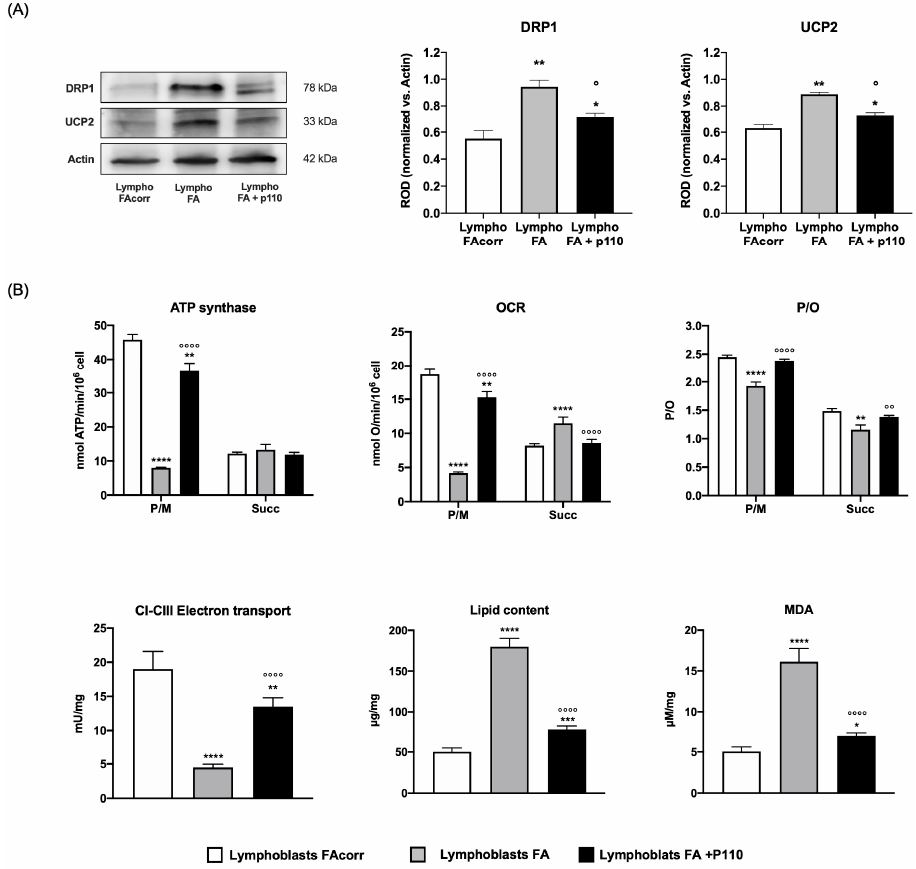
Figure 5. Effect of P110 treatment on DRP1 and UCP2 expression and energy metabolism in lymphoblasts mutated for the FANC-A gene. ( A ) WB signals of DRP1 (mitochondrial fission), UCP2 (uncoupling protein 2), and Actin (housekeeping protein used for signals normalization) expression in FAcorr lymphoblasts and FA lymphoblasts treated or not with P110. For all the densitometry graphs, protein expression levels were normalized on the housekeeping signal (Actin), revealed on the same membrane. ( B ) Energy and lipid metabolism in FAcorr and FA lymphoblasts treated or not with P110: ATP synthesis, oxygen consumption rate (OCR), and P/O value obtained after stimulation with pyruvate/malate (P/M) or succinate (Succ); electron transport between complexes I and III (CI-CIII); cellular lipid content; malondialdehyde (MDA) level, as a marker of lipid peroxidation. All the WB signals reported in ( A ) are representative of at least three independent experiments. In each panel, data are reported as mean ± SD, and each graph is representative of at least three independent experiments. Statistical significance was tested appropriately with a one-way ANOVA or an unpaired t -test; *, **, ***, and **** represent a significant difference for p < 0.05, 0.01, 0.001, and 0.0001 between FA cells and the FAcorr cells used as control; °, °°, and °°°° represent a significant difference for p < 0.05, 0.01, and 0.0001 between FA cells untreated and treated with P110.